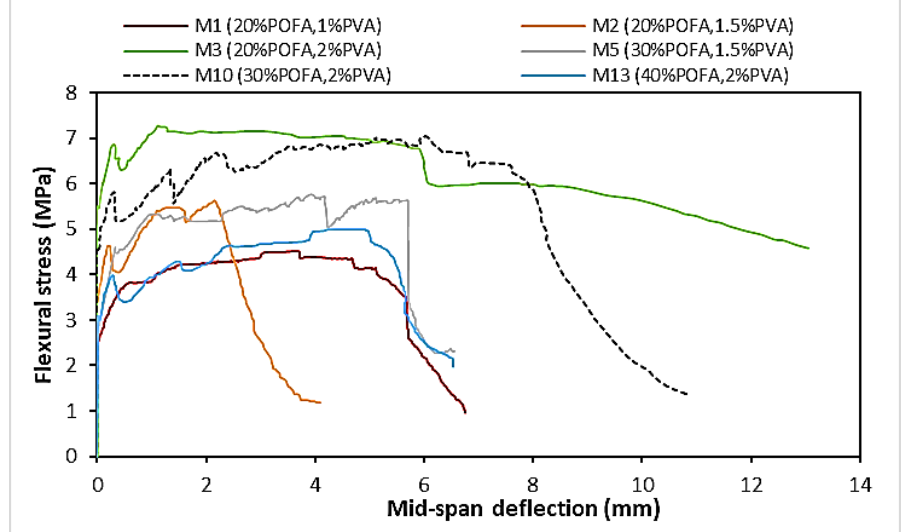
Figure 11. Load-deflection curves for POFA-ECC mixes .